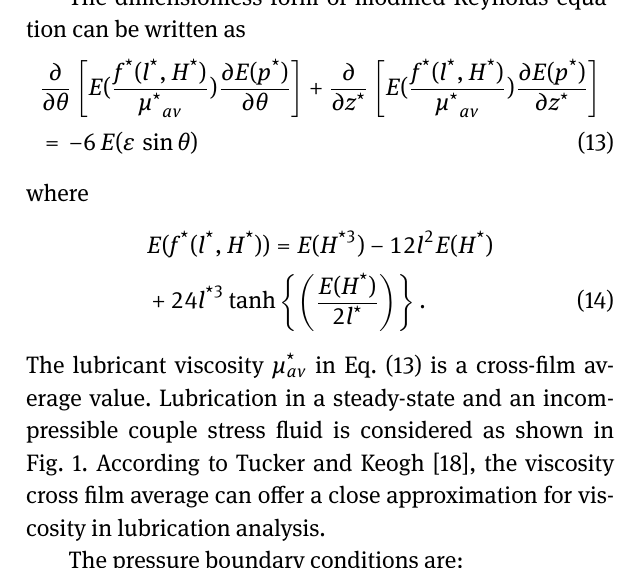
The velocity boundary conditions at the bushing surface